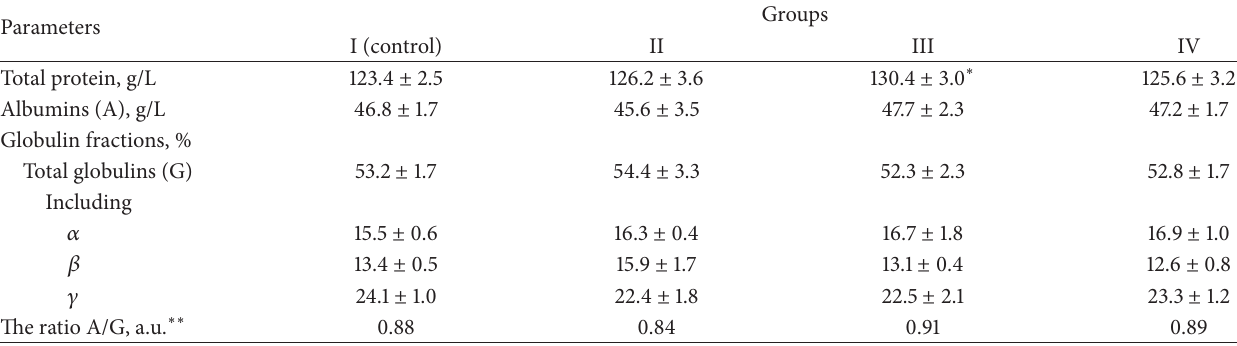
Table 2: Basic indicators of the “protein spectrum” of mink blood samples taken from the control (I) and experimental (II–IV) animal groups (received